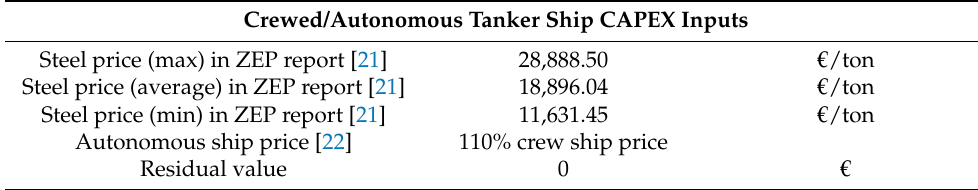
Table 14. Crewed/autonomous tanker ship CAPEX inputs.